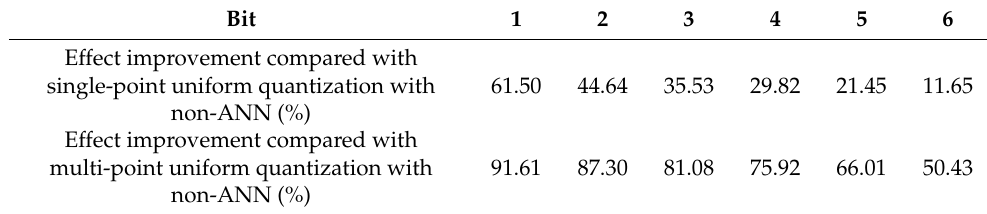
Table 5. Improvement in PRD using the overall algorithm.